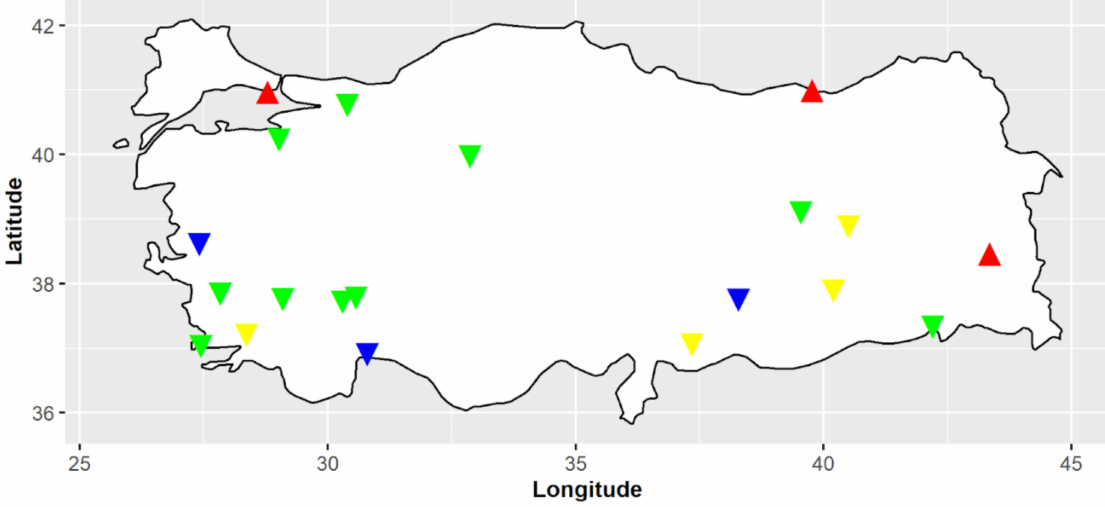
Figure A18. Same as Figure A13 but for May (See Figure A13 for legend).